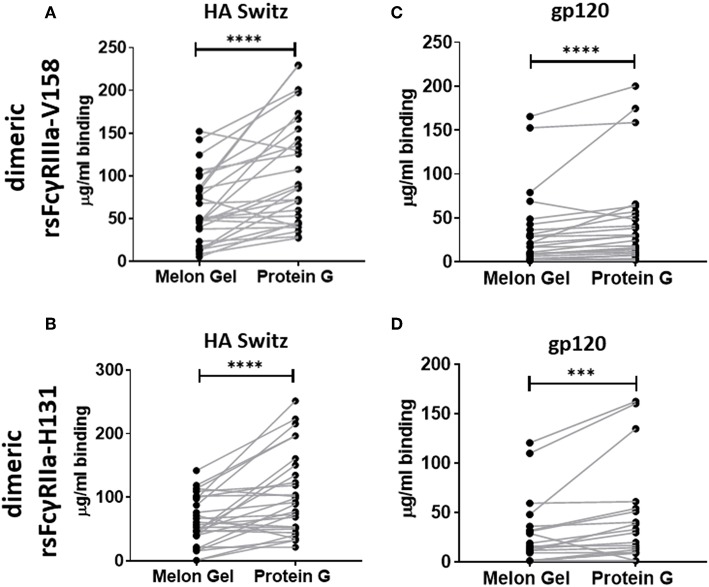
Dimer ELISA binding Ab responses to HA from A/Switzerland/9715293/2013 (H3N2) (HA Switz) for FcγRIIIa V158 n = 28 (A) and FcγRIIa H131 (B) and HIV gp120 protein (C,D)
n = 25. IgG samples were serially diluted 4-fold from a starting concentration of 100 μg/ml. Melon Gel and Protein G responses were compared using the Wilcoxon matched-pair test. ***p ≤ 0.001; ****p ≤ 0.0001.